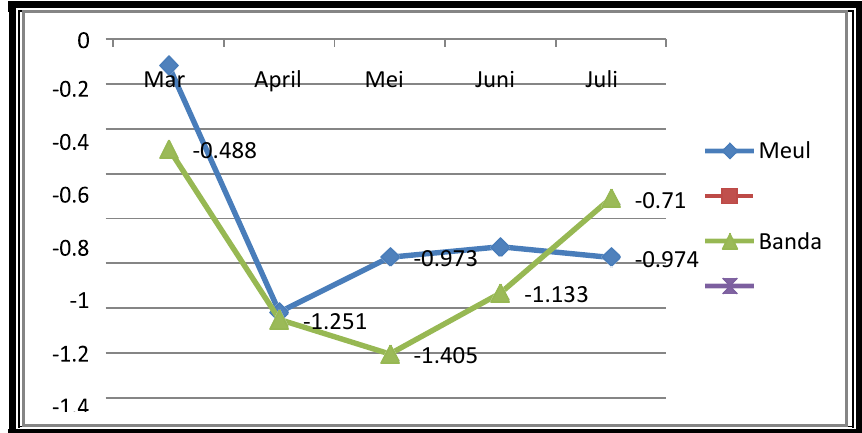
Figure 3 Change Requests Price elasticity smoking between March and July